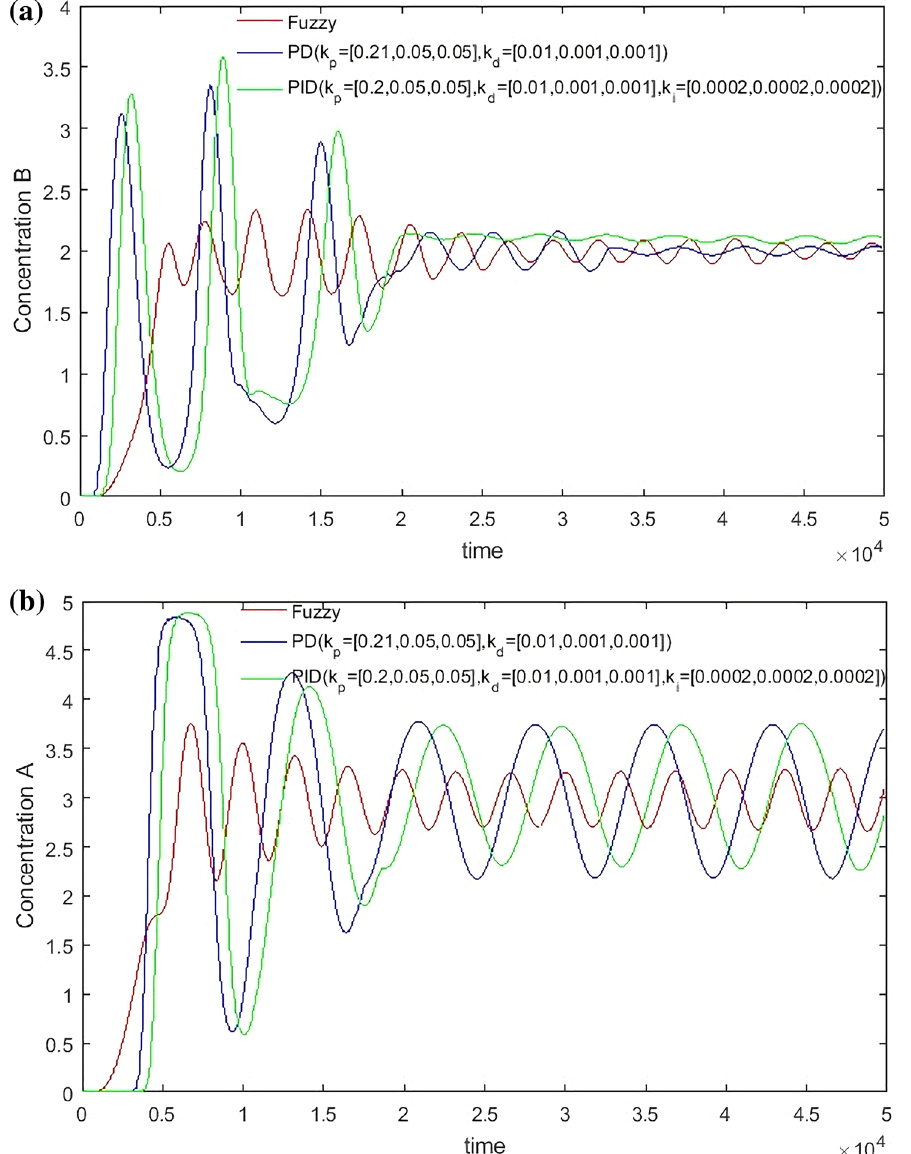
Figure 15. Desired B = 2, desired A = 3, Switch time = 180